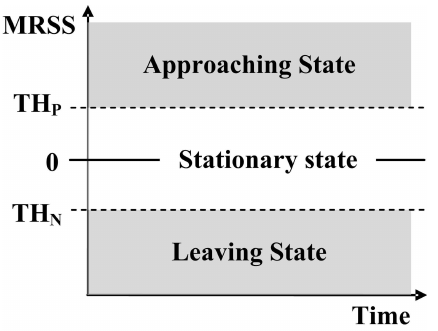
Figure 2. The detected user motion state of the MRSS